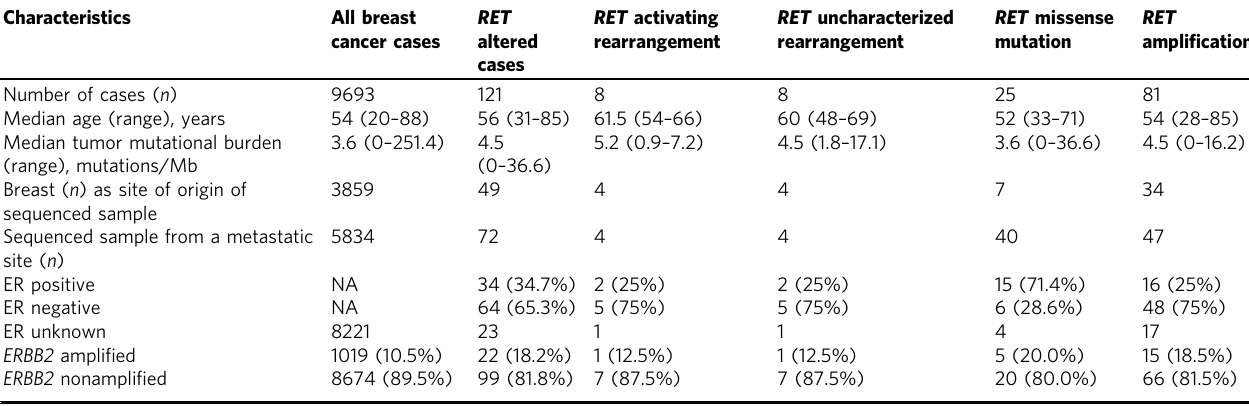
Table 1 Clinicopathologic characteristics of RET altered breast cancers